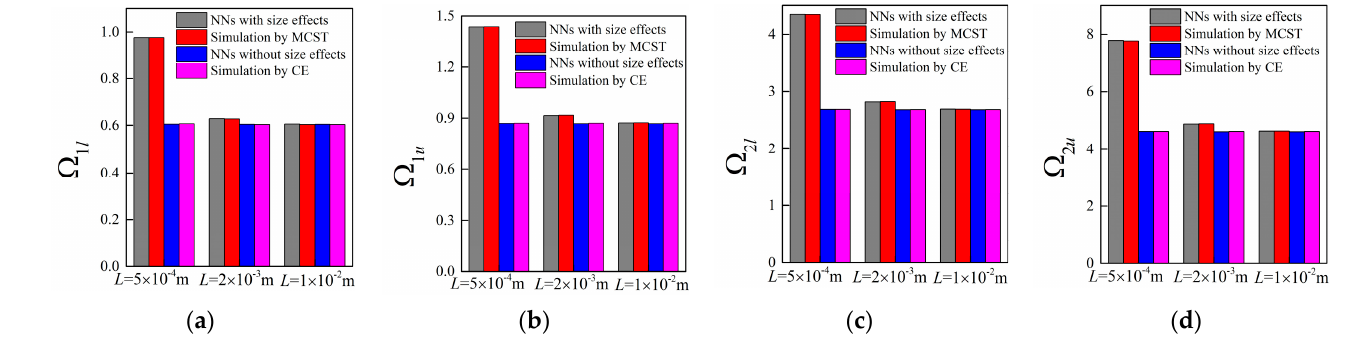
( d ) Figure 7. The predictions for bounding frequencies of size-dependent and size-independent band gaps of random example 3: ( a , b ) the lower and upper boundary of the first band gap; ( c , d ) the lower and upper boundary of the second band gap. ( a ) ( d ) Figure 8. The predictions for bounding frequencies of size-dependent and size-independent band gaps of random example 4: ( a , b ) the lower and upper boundary of first band gap; ( c , d ) the lower and upper boundary of the second band gap. Obviously, with the increase of L , the size-dependent Bragg band gaps move towards lower frequencies and the NN model can reflect the trend accurately. In contrast, as ob- served from the NN and TMM models without size effects, the location of the stop bands depicted by normalized frequencies is insensitive to the unit cell length. In addition, the differences caused by the scaling effects are diminished as the unit cell length increases. From the following plots, one can notice that these values are merely overlapped when L is modified to 0.01m. 3.3. Inverse Design of Micro-PnC Beams